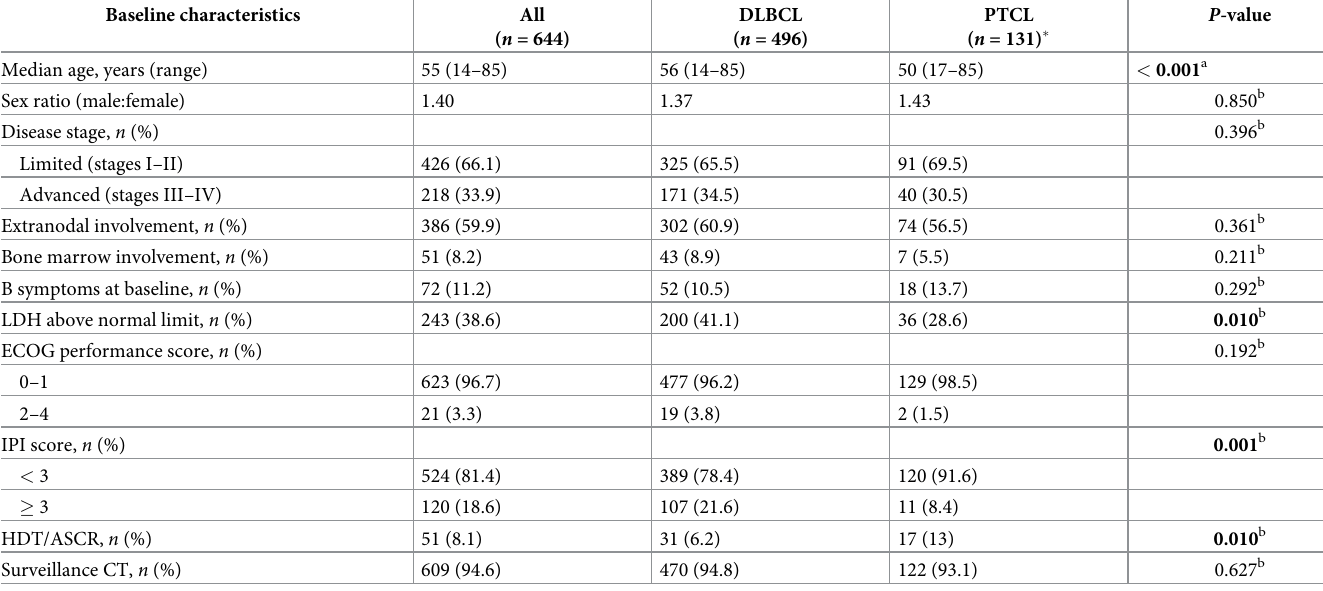
Table 1. Baseline characteristics at diagnosis in patients who achieved complete remission after frontline